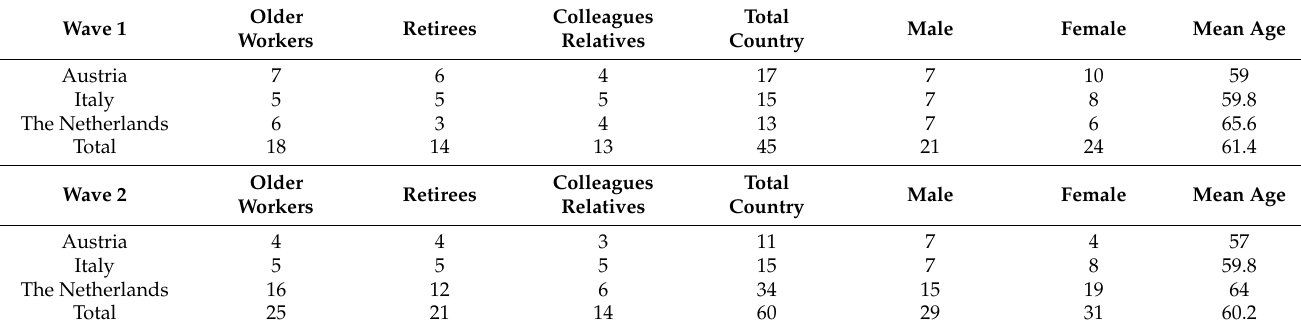
Table 1. Description of participants to the two waves of focus-groups in Austria, Italy and the Netherlands. Older Wave 1 Retirees Workers